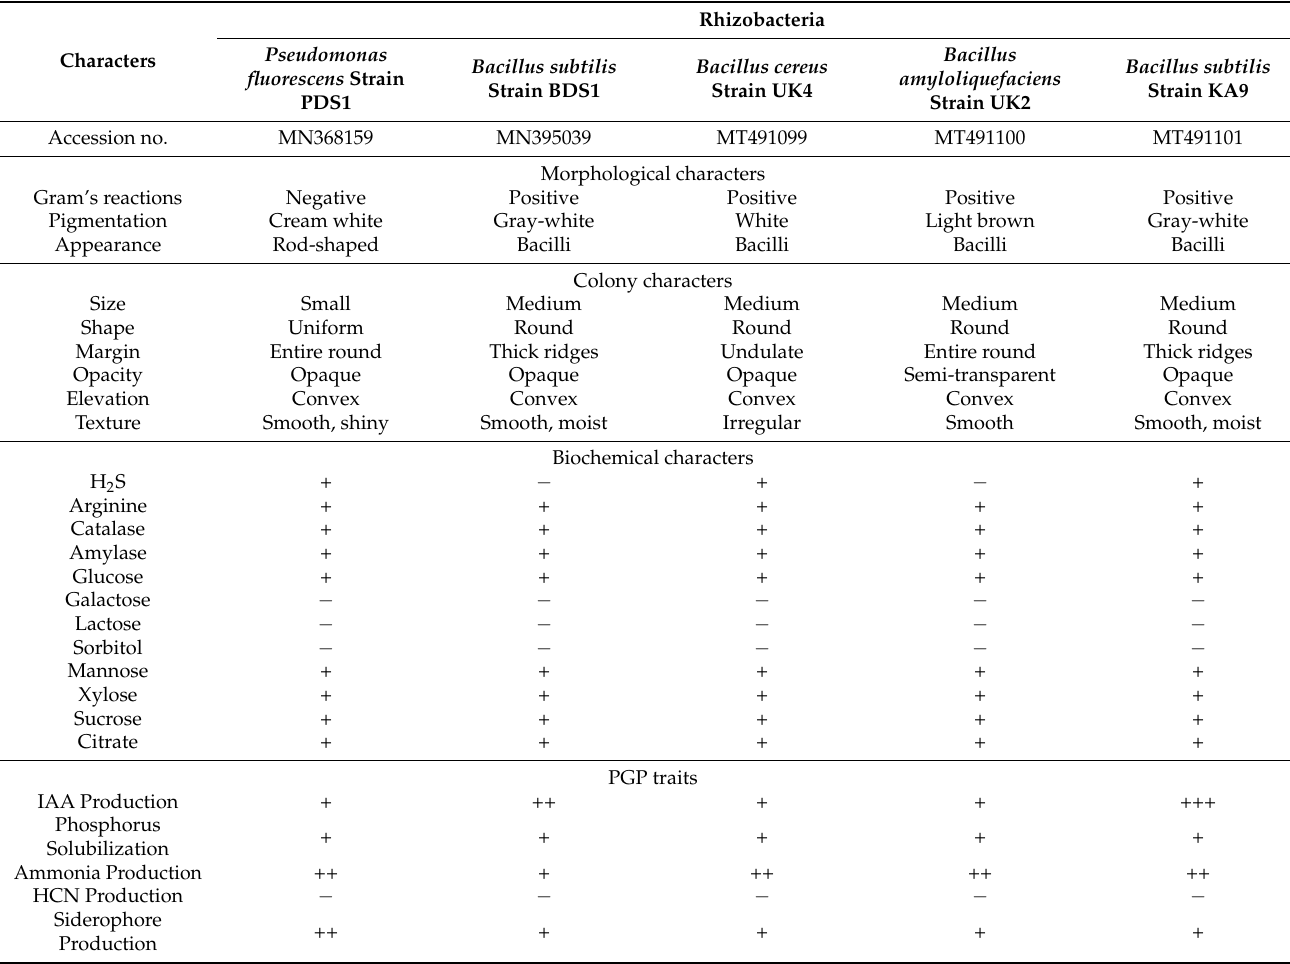
Table 4. Characterization of best five rhizobacterial isolates from the chilli rhizosphere in the hilly regions of Uttarakhand and Central plain of Karnataka, India.